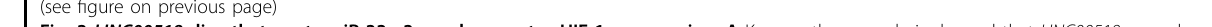
Fig. 3 LINC00518 directly targets miR-33a-3p and promotes HIF-1 α expression. A Kegg pathway analysis showed that LINC00518 may play a major role in glycolysis and TCA cycle. B Cytoscape was used to visualize LINC00518 − miRNA − target gene interactions. The LINC00518 /miRNAs interaction was predicted using RegRNA 2.0 and miRbase, the target genes of the miRNAs were predicted by combing GEO and TCGA databases with miRNA target prediction tools (microRNA.org and TargetScan). Red color demonstrates high expression level in CMM, and blue color demonstrates low expression level. C The expression levels of miR-33a-3p, miR-27a-3p, miR-18a-3p, miR216-5p, and miR-100-3p in melanoma cells following transfection with LINC00518 shRNA or NC. D The miR-33a-3p expression pro fi le in human melanoma cell lines (WM35, WM451, A375) and human epidermal melanocytes (HM). E The HIF-1 α expression pro fi le in human melanoma cell lines (WM35, WM451, A375) and human epidermal melanocytes (HM). F Presumptive binding sites for miR-33a-3p were identi fi ed in the LINC00518 sequence and in the HIF-1 α 3 ′ UTR by using sequence comparison and RegRNA data. G Negative correlation between LINC00518 and miR-33a-3p expressions in 12 cases of CMM tissues using Pearson correlation analysis. H RNA pull-down depicting that the bio-miR-33a-3p group was enriched for larger amounts of LINC00518 than the bio- miR-NC and bio-miR-33a-3p-MUT groups, thereby indicating that LINC00518 can target miR-33a-3p directly. I A dual-luciferase assay showing that miR-33a-3p mimics directly and signi fi cantly inhibited the relative dual-luciferase activity of the LINC00518-WT group compared with that of control group and LINC00518 targeted miR-33a-3p. Luciferase activity was detected 48 h after transfection. J qPCR assay showing a negative correlation between miR-33a-3p and HIF-1 α expressions in 12 cases of CMM tissues. K Dual-luciferase assay of cells transfected with HIF-1 α -3 ′ UTR-WT or HIF-1 α - 3 ′ UTR-MUT reporter together with miR-33a-3p mimic, LINC00518 shRNA, or LINC00518 shRNA plus miR-33a-3p inhibitor. L The changes of HIF-1 α mRNA expression in WM451 and A375 transfected with miR-33a-3p mimic, LINC00518 shRNA, or LINC00518 shRNA plus miR-33a-3p inhibitor. M Western blotting analysis showing that HIF-1 α and LDHA protein levels were regulated by LINC00518 and miR-33a-3p. The histogram data for each group are an average of three independent replicates; bars indicate SD; * P < 0.05, ** P < 0.01, *** P <